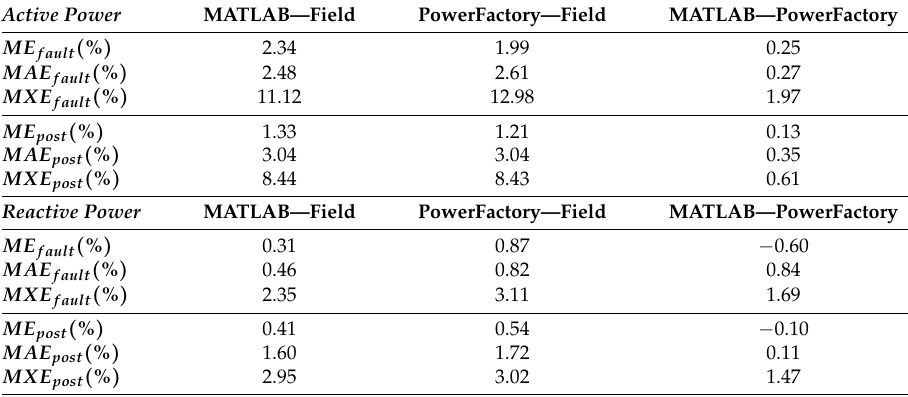
Table 3. Validation errors of Test Case 1: u = 0.50 pu, t = 920 ms.